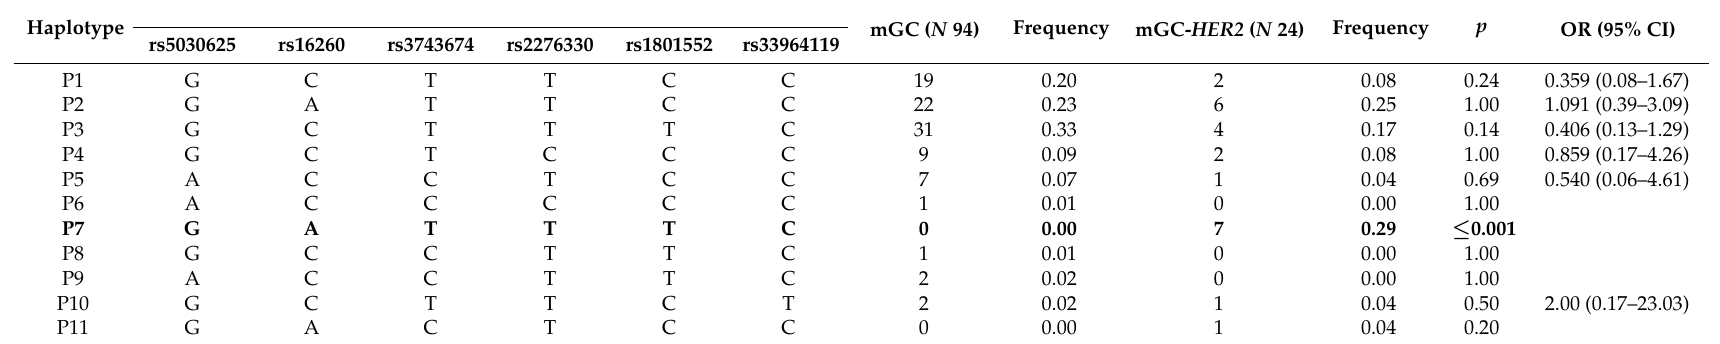
Table 3. Haplotype analysis in patients with mGC according to HER2 expression.